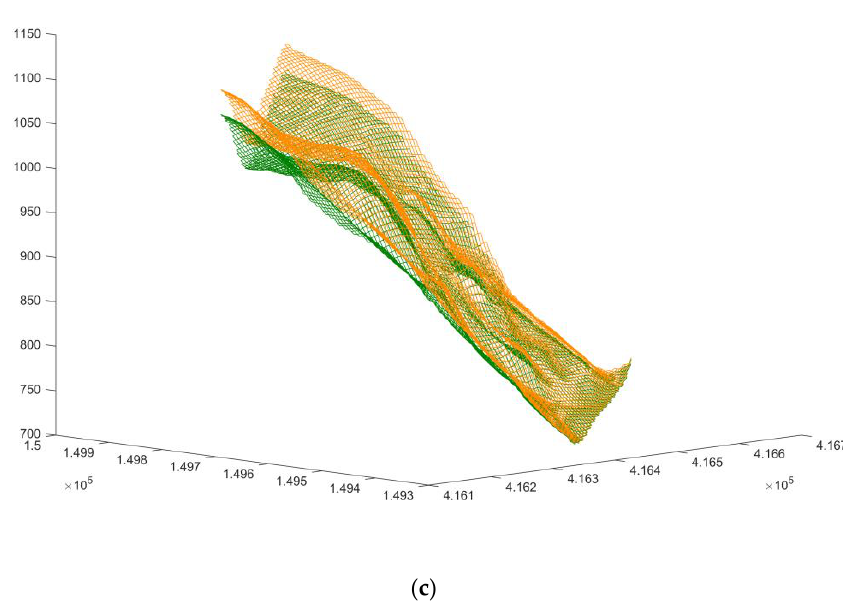
Figure 8. DEMs and tilted DEMs: ( a ) UAV flight heights when the basic DEM is used for mission planning; ( b ) UAV flight heights when the tilted DEM is used for mission planning and ( c ) a 3D comparison of NDTM (green) and tilted NDTM (dark orange) of the case study.